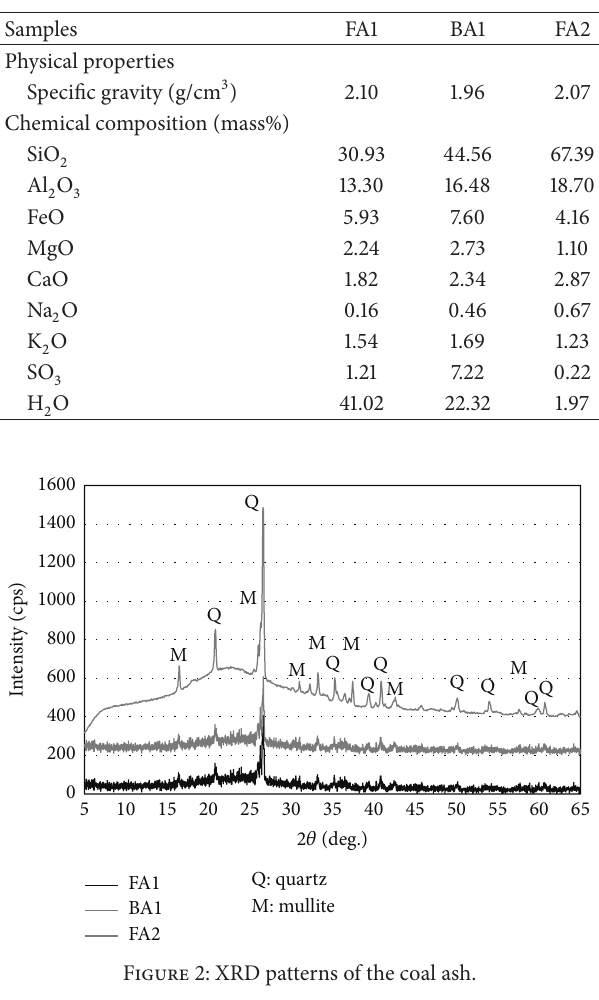
Table 1: Physical and chemical properties of the coal ash.